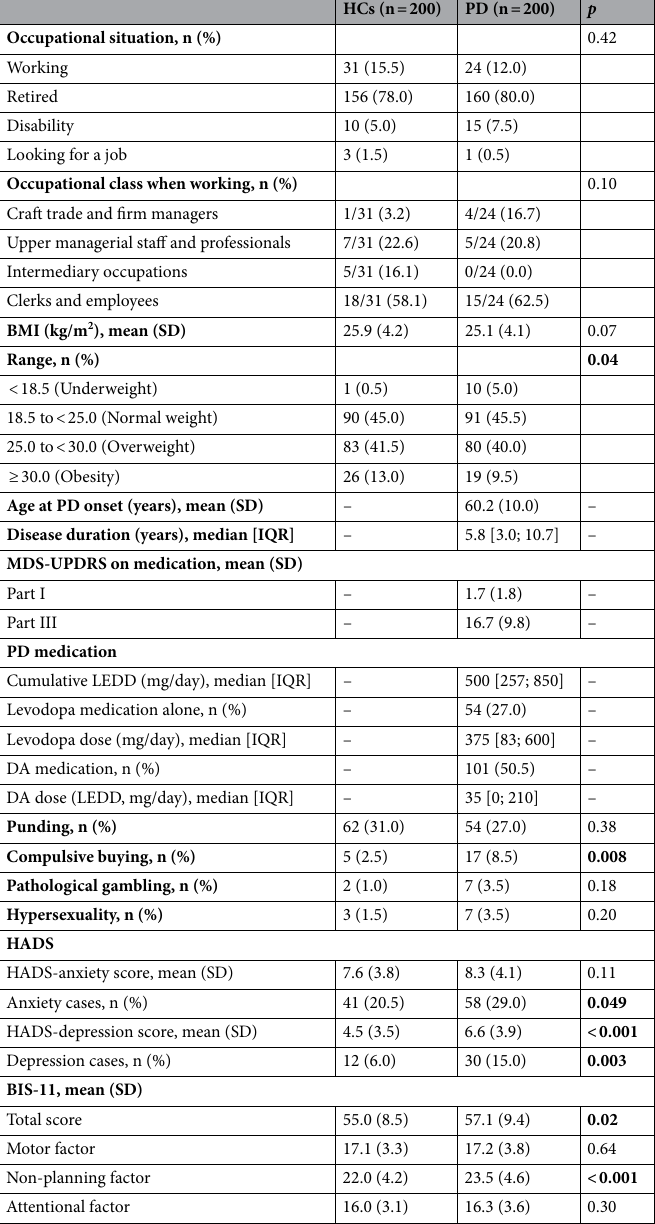
Table 1. Description of HCs and patients with PD (n = 400). Bold values indicate statistical significance ( p < 0.05). BMI body mass index, BIS-11 Barratt impulsiveness scale, DA medication dopamine agonist medication, HADS hospital anxiety and depression scale, HCs healthy controls, IQR interquartile range, LEDD levodopa equivalent daily dose, MAO-I monoamine oxidase inhibitor, MDS-UPDRS movement disorder society-unified Parkinson’s disease rating scale, PD Parkinson’s disease, SD standard